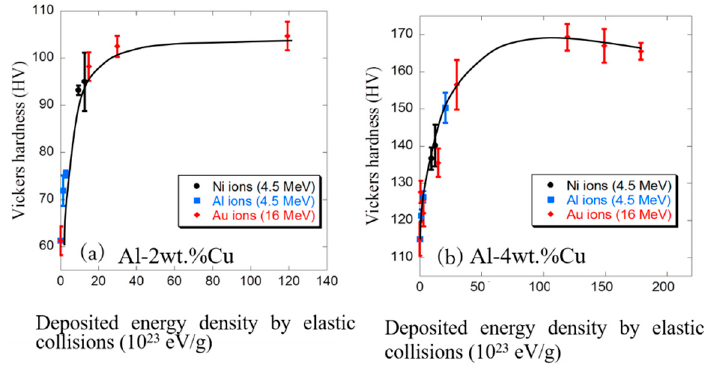
Figure 4. Elastically deposited energy density dependence of Vickers hardness of ( a ) Al-2wt %Cu alloy and ( b ) Al-4wt %Cu alloy for three kinds of ion irradiations.